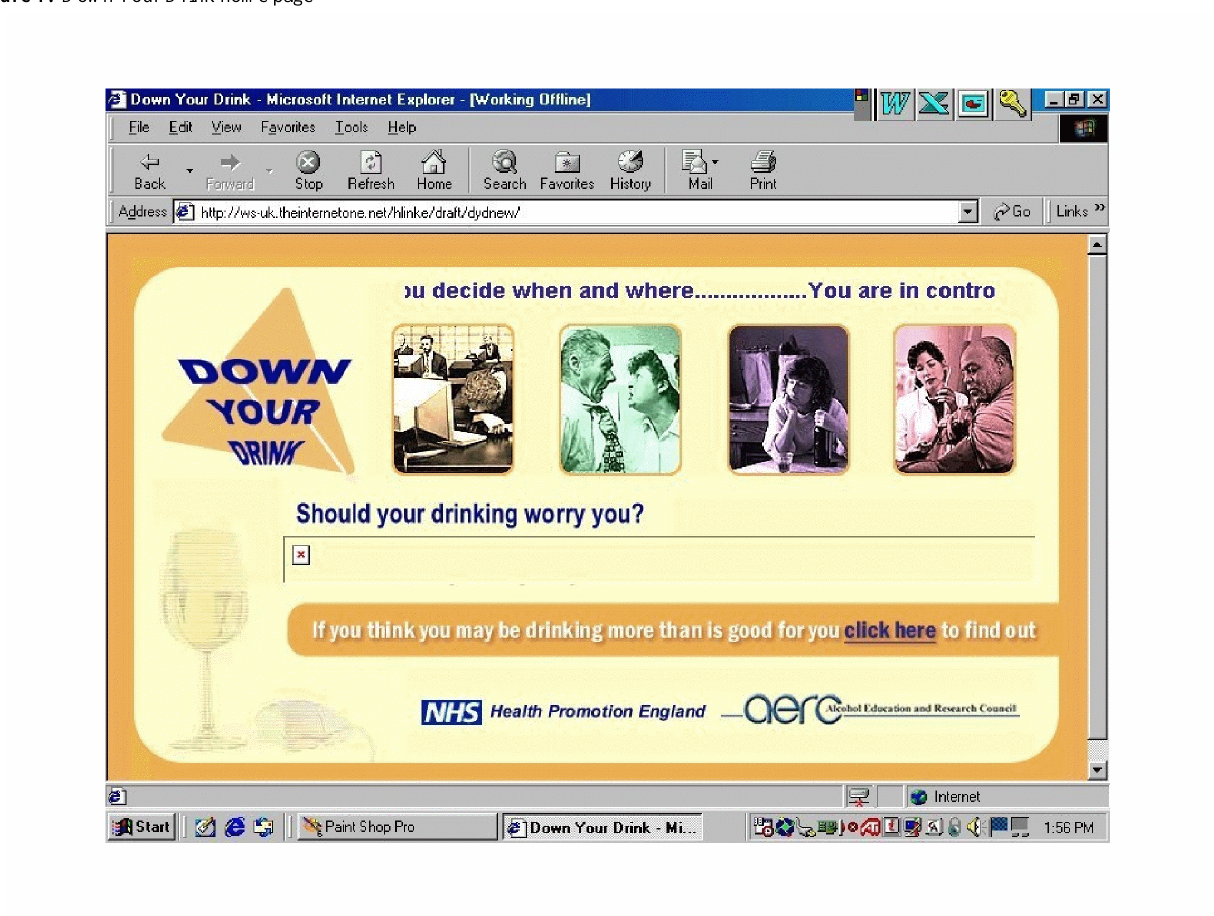
Figure 1. Down Your Drink home